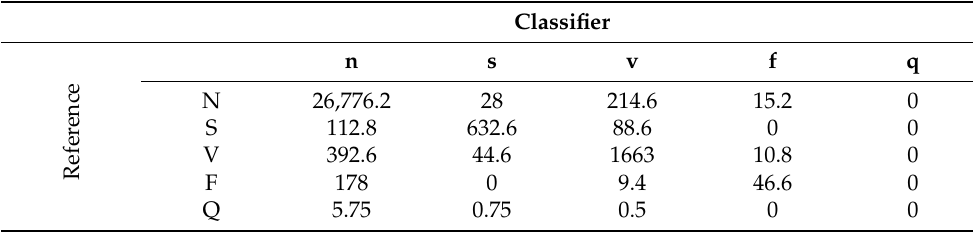
Table 12. Confusion matrix ANN.